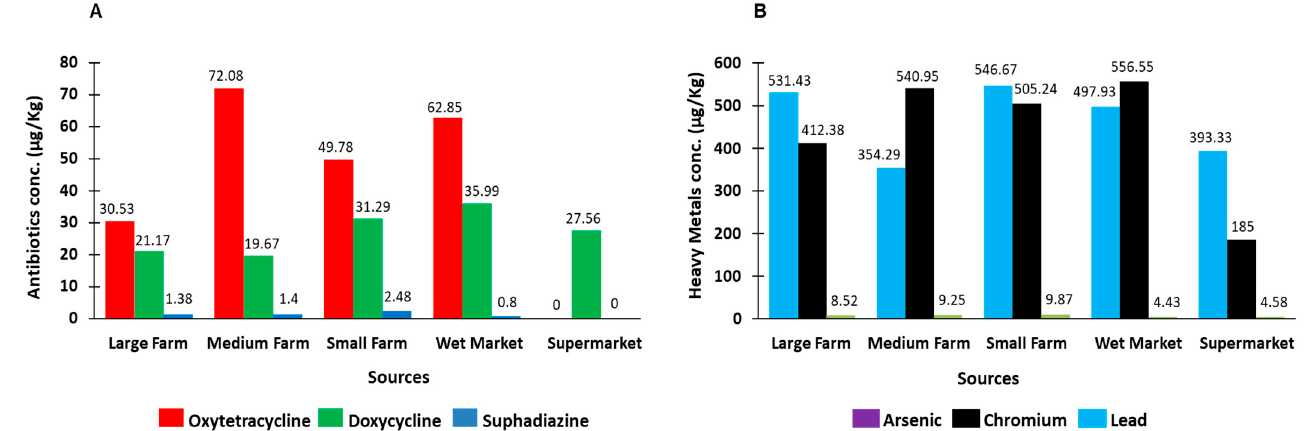
Figure 3. Concentration of antibiotic residues ( A ) and heavy metals ( B ) in broiler bone collected from various large farms, medium farms, small farms, broiler wet meat markets and supermarkets in Bangladesh.